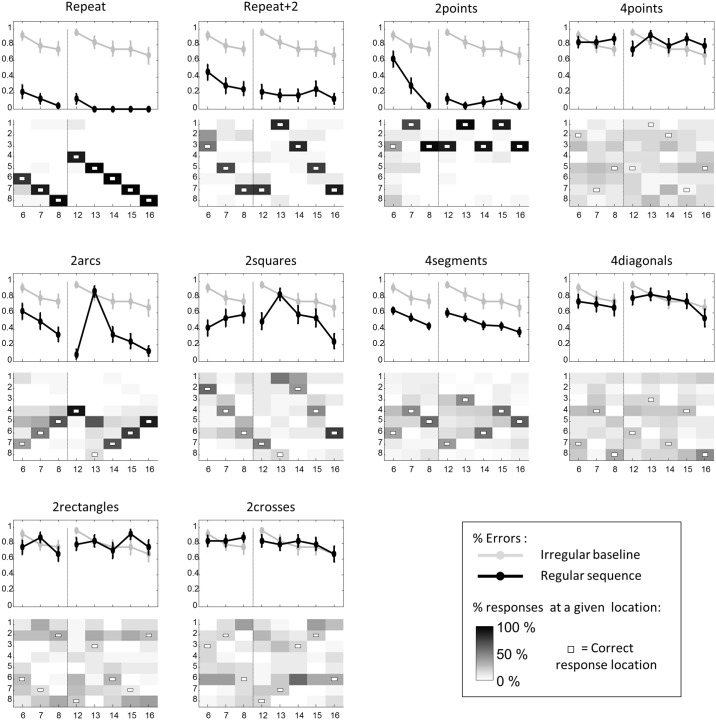
Performance of preschool children in experiment 2.Same format as Fig 2. In children, only data points 6 to 8 and 12 to 16 were collected. Vertical dashed lines indicate the transition between the first and the second presentations of the 8-item sequences.